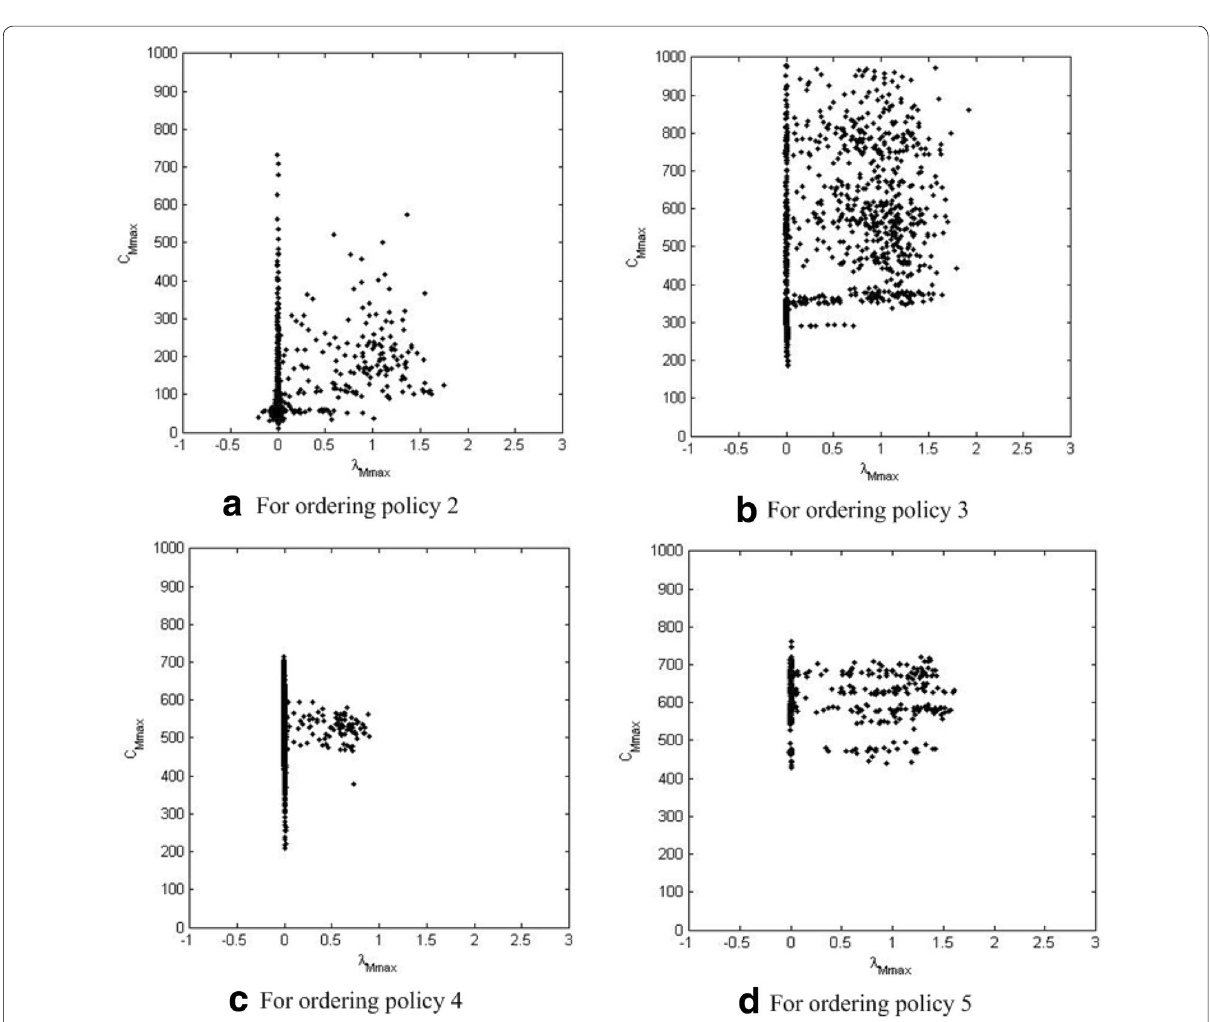
Figure 8 Relation between C M and (cid:31) M max for the manufacturer in the case of different ordering